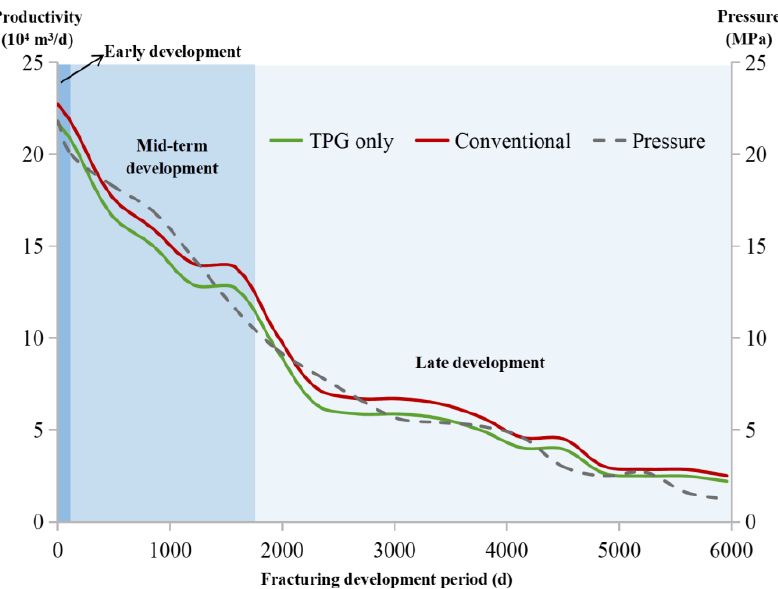
Figure 11. The pollution effect on gas reservoir production under the condition of only threshold pressure gradient pollution. pressure gradient